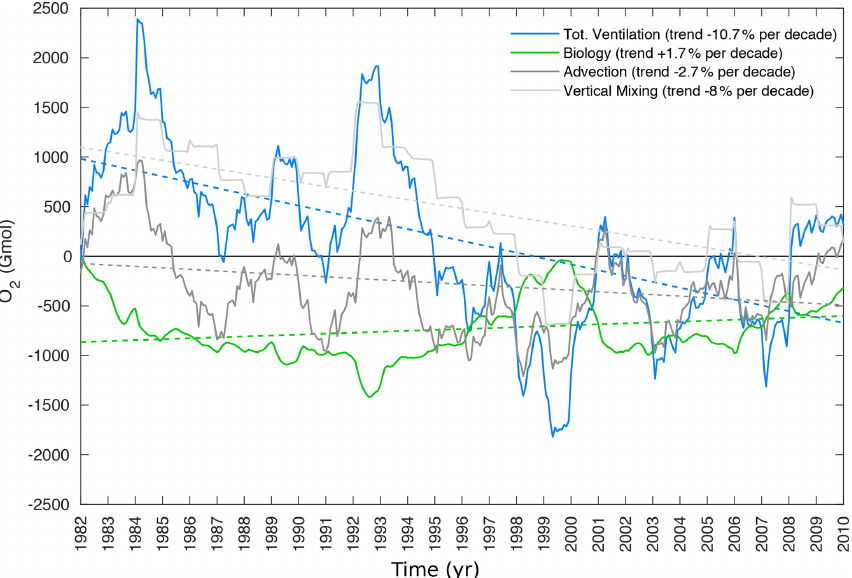
Figure 7. Role of ventilation and biology in northern AS deoxygenation. Cumulative O 2 anomalies associated with ventilation (blue) and biological (green) changes between 100 and 1000m in the northern AS (location indicated in Fig. 4a). The contributions of advection and subgrid vertical mixing are shown in dark gray and light gray, respectively. The dashed lines indicate the trend lines associated with the different